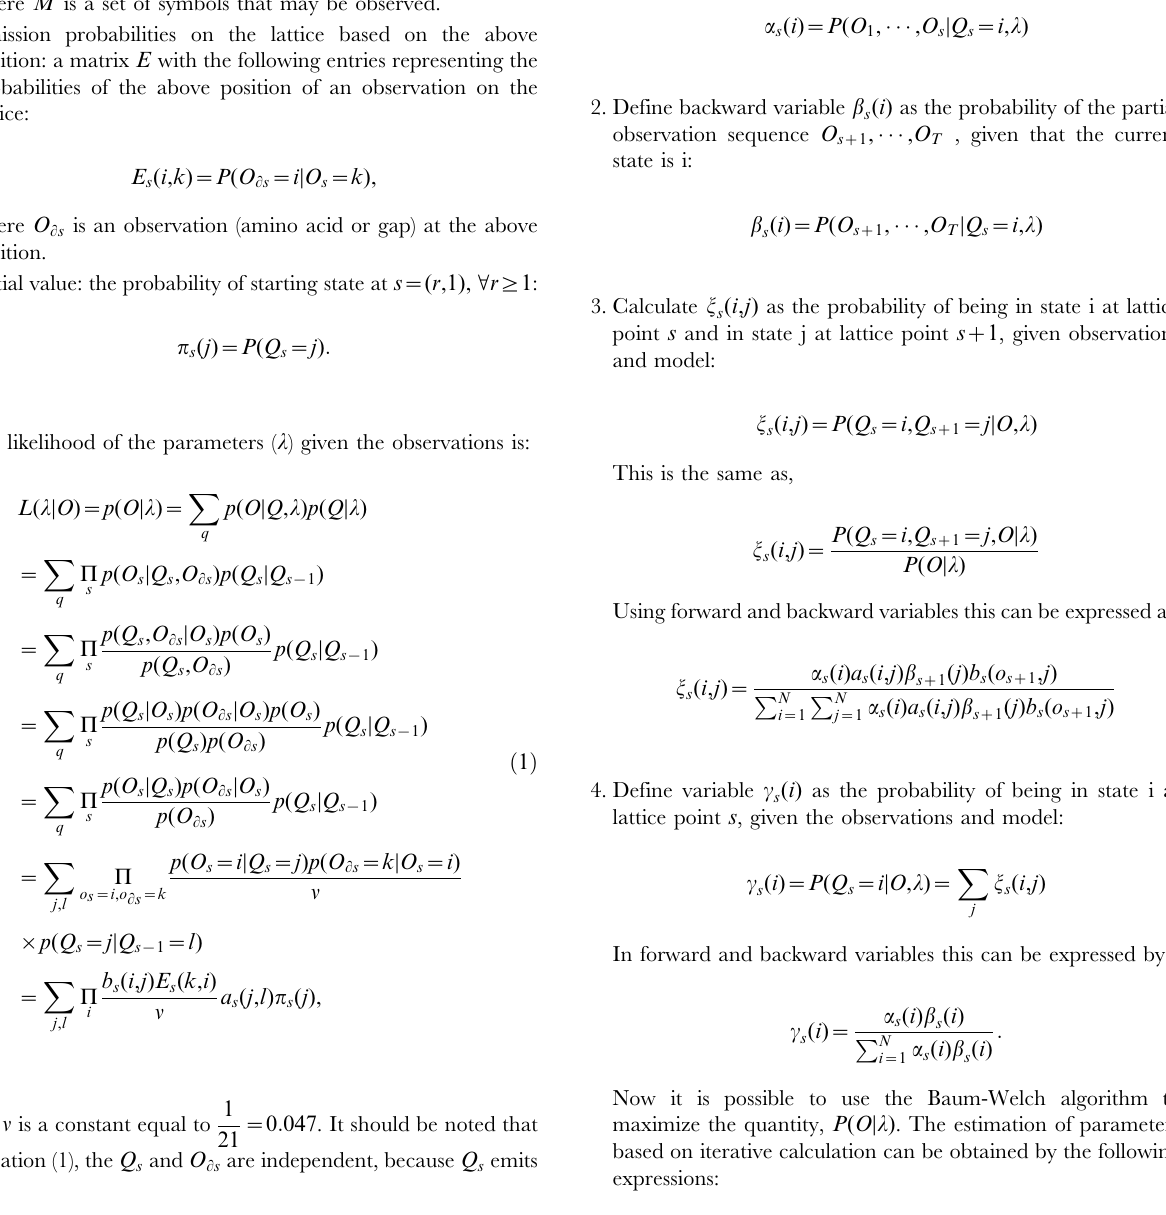
Table 1. An example of the dependency between corresponding